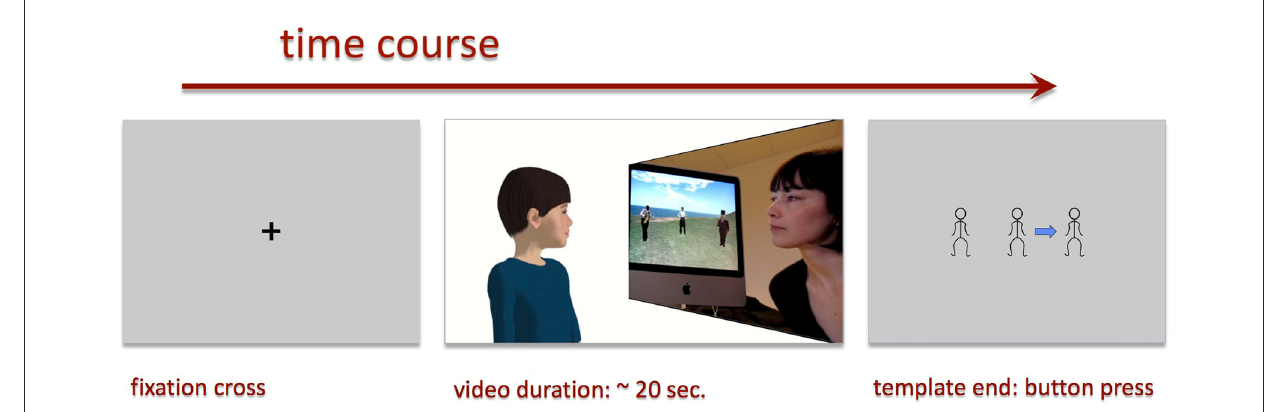
FIGURE1 The time course of a typical trial in all four experiments: the fixation cross, the video clip, and the template. Adapted from Nunnemann (2021, p. 71).